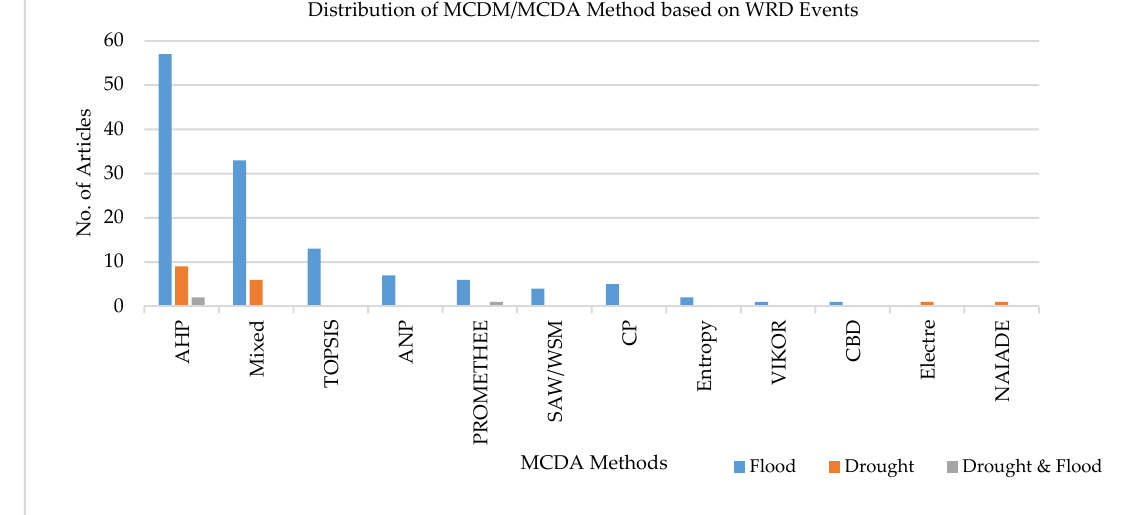
Figure 4. Distribution of MCDA techniques based on WRD events.